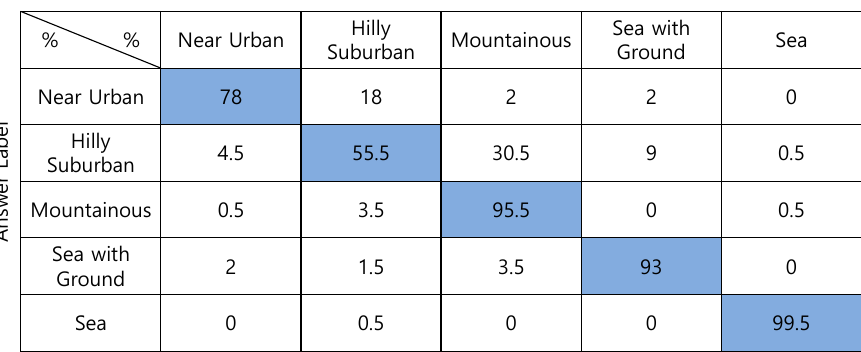
Figure 11. Confusion matrix of classification by a human.